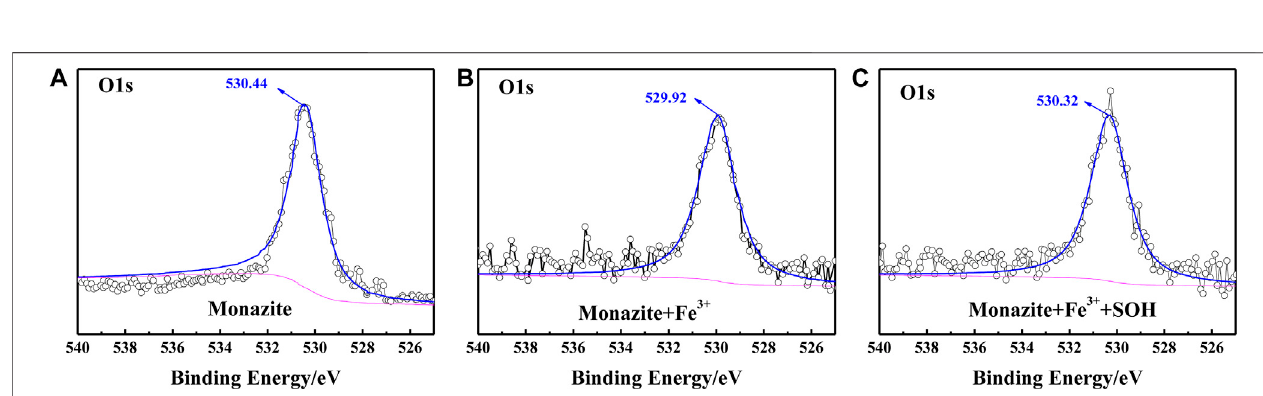
FIGURE 8 | O1s XPS spectrum on the (A) pure monazite surface, (B) monazite surface treated with Fe 3+ , and (C) monazite surface treated with Fe 3+ and SOH, respectively.